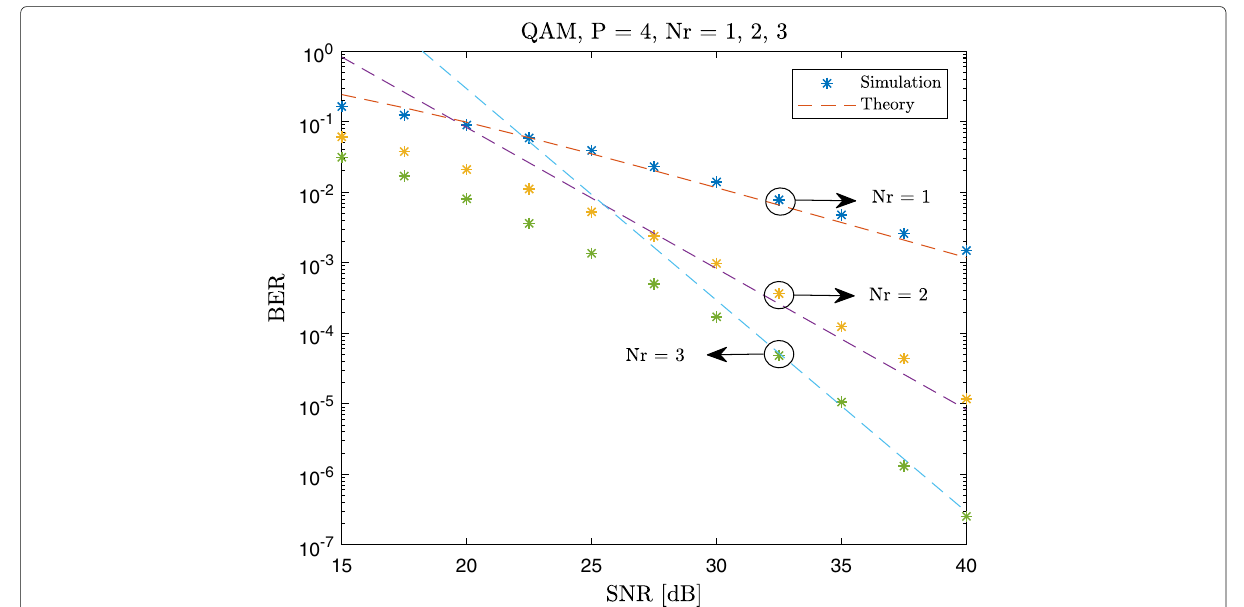
Fig. 11 ABEP of RecAnt-SM ( P = 4, N r = 1,2,3, M = 4 (QPSK)). The results are obtained by using RP 1 -RP 4